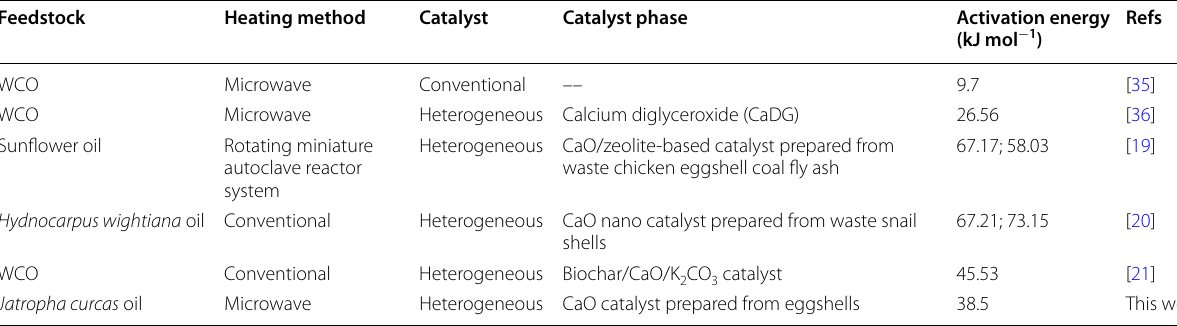
Reaction temperatures 45, 55, 65, 75 and 85 ºC; Reaction time = Table 4 Activation energy ( E ) on transesterification reaction of biodiesel production from different studies a